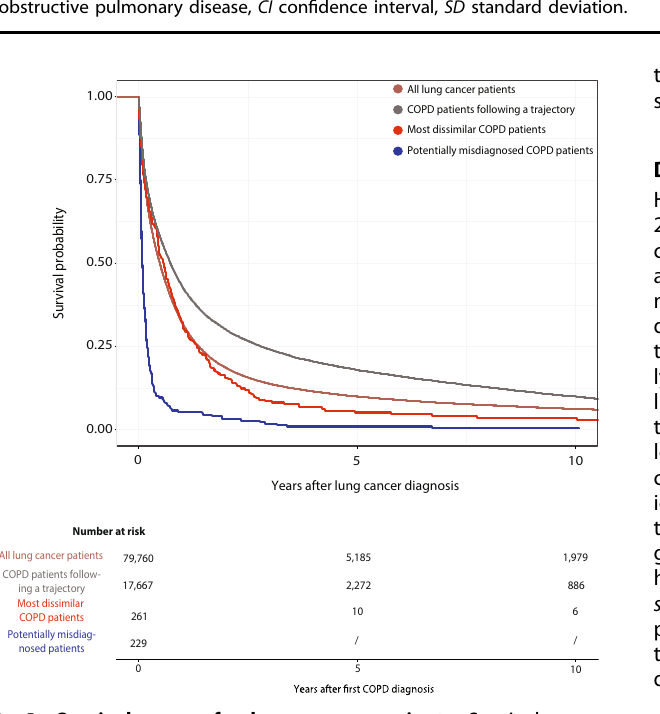
Fig. 5 Survival curves for lung cancer patients. Survival curves comparing four groups of lung cancer patients. One group that include all 79,760 lung cancer patients diagnosed in the Danish National Patient Registry (brown) without the chronic obstructive pulmonary disease (COPD) and three groups of lung cancer patients also diagnosed with COPD. The 17,667 COPD patients that follow a trajectory, the 261 most dissimilar COPD patients and the 229 patients that die fast after COPD diagnosis. Being a dissimilar patient, and especially a misdiagnosed patient that die within the fi rst 0.4 years after COPD diagnosis, results in worse survival of lung